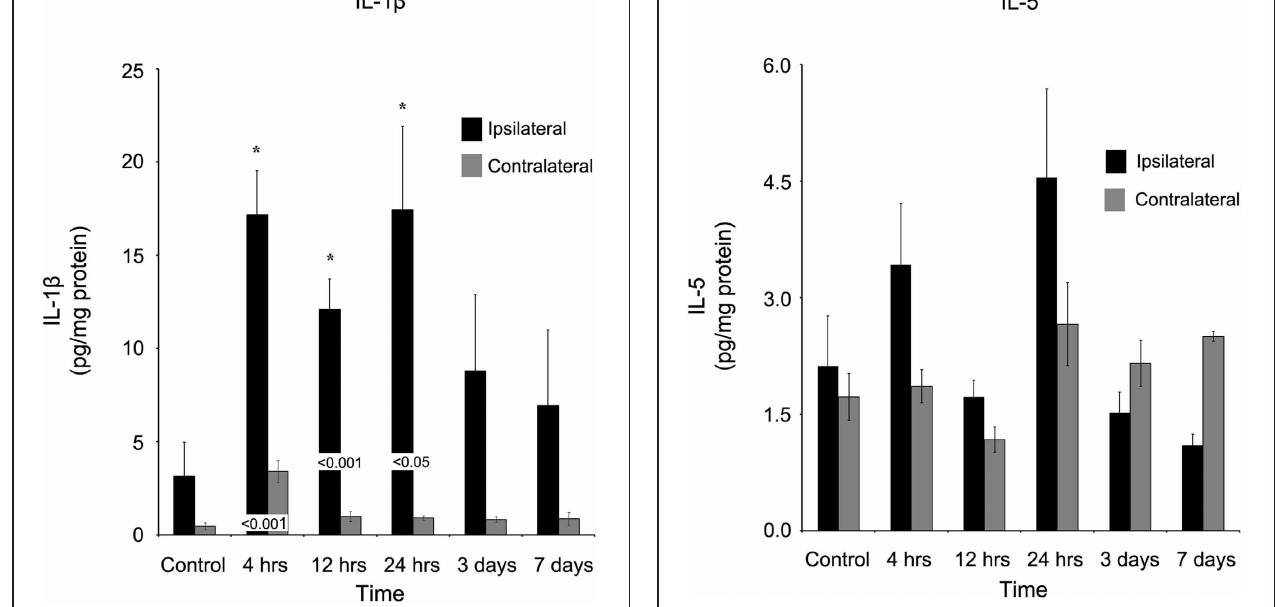
FIGURE 8 | IL-1 β concentrations increase in the ipsilateral cortex following a controlled cortical impact. Within four hours of a brain injury, IL-1 β increases ( p < 0 . 05) in the ipsilateral cortex in comparison to both control and contralateral tissue. The expression of IL-1 β remained elevated for the first 24 hours after injury, and did not return to levels observed in control or contralateral tissue ( p > 0 . 05) until three days post-injury. At no time, was the expression of IL-1 β observed to be elevated ( p > 0 . 05) in the contralateral cortex in comparison to control. All values are mean ± SEM, n = 5. ∗ At each time point noted, ipsilateral differs from control tissue, p < 0 . 05. Differences between the ipsilateral and contralateral cortices are denoted by placing the appropriate p -value above the two bars.